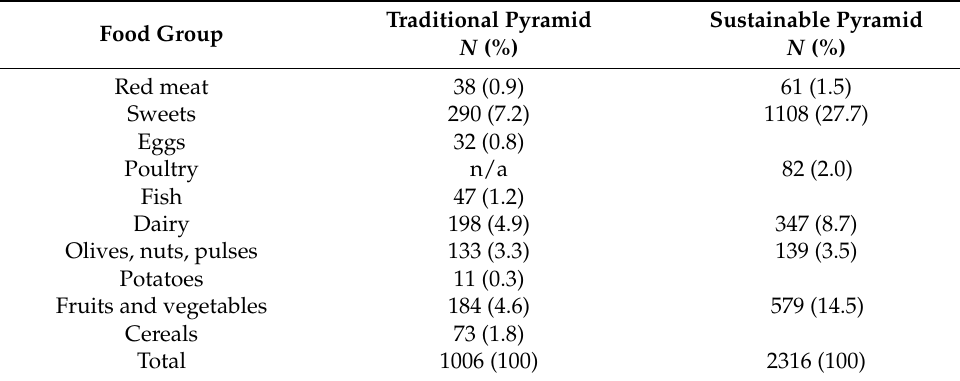
Table 1. Distribution of the foods available in HelTH ( n = 4002) within the traditional and the sustainable Mediterranean diet pyramid food groups (food groups in the table are not presented according to their ranking in the Mediterranean diet